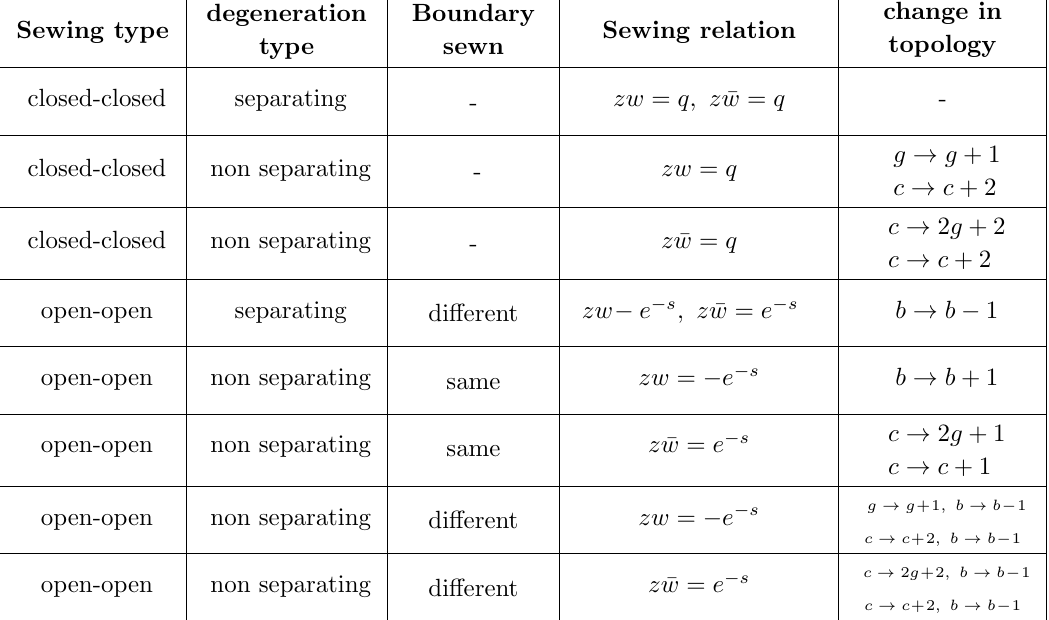
Table 1 . Relation between the topology of the sewed surface to the topology of the surface(s) before sewing. The last column of some of the rows have two entries. The top entry refers to the case where the original surface before sewing is oriented, while the bottom entry refers to the case where the original surface was